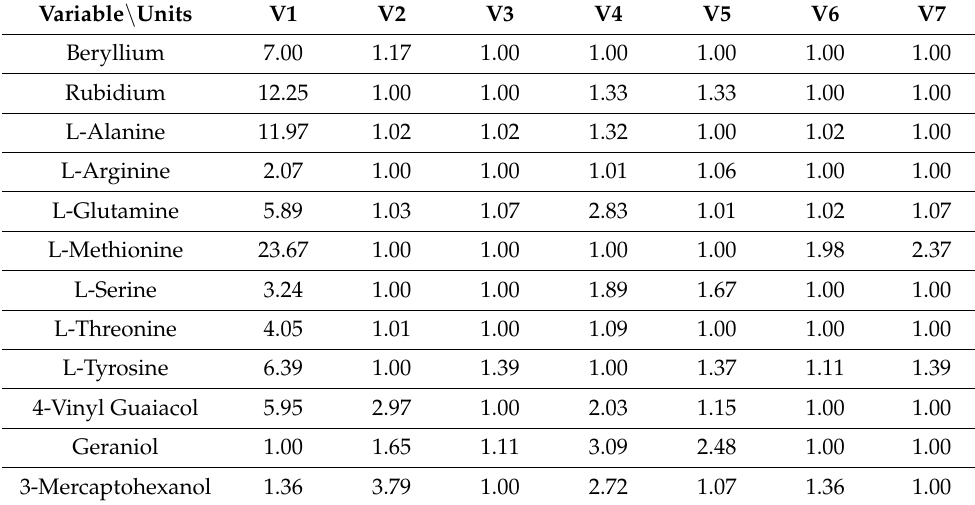
Table 10. Grubbs and Dixon